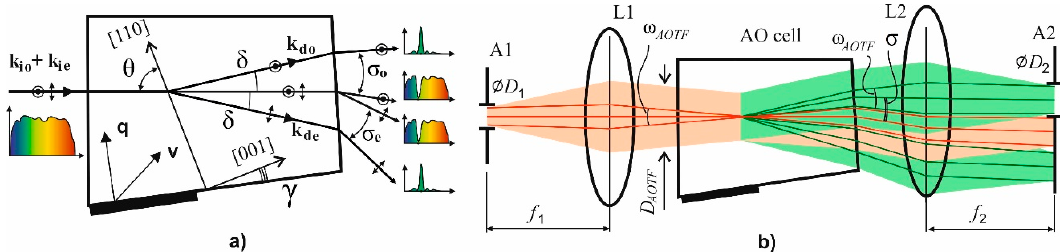
Figure 3. The principle optical schemes of the light beam diffraction and filtration ( a ) and an imaging system based on an acousto-optical tunable filter (AOTF) ( b ). Only one diffracted beam passes through the system, while others are stopped.